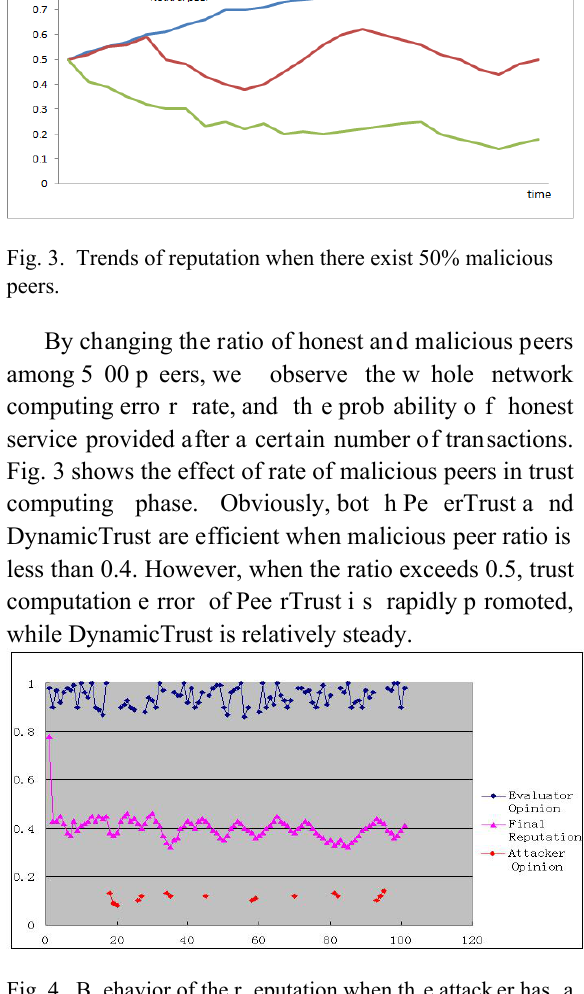
Fig. 4. B ehavior of the r eputation when th e attack er has a random personal